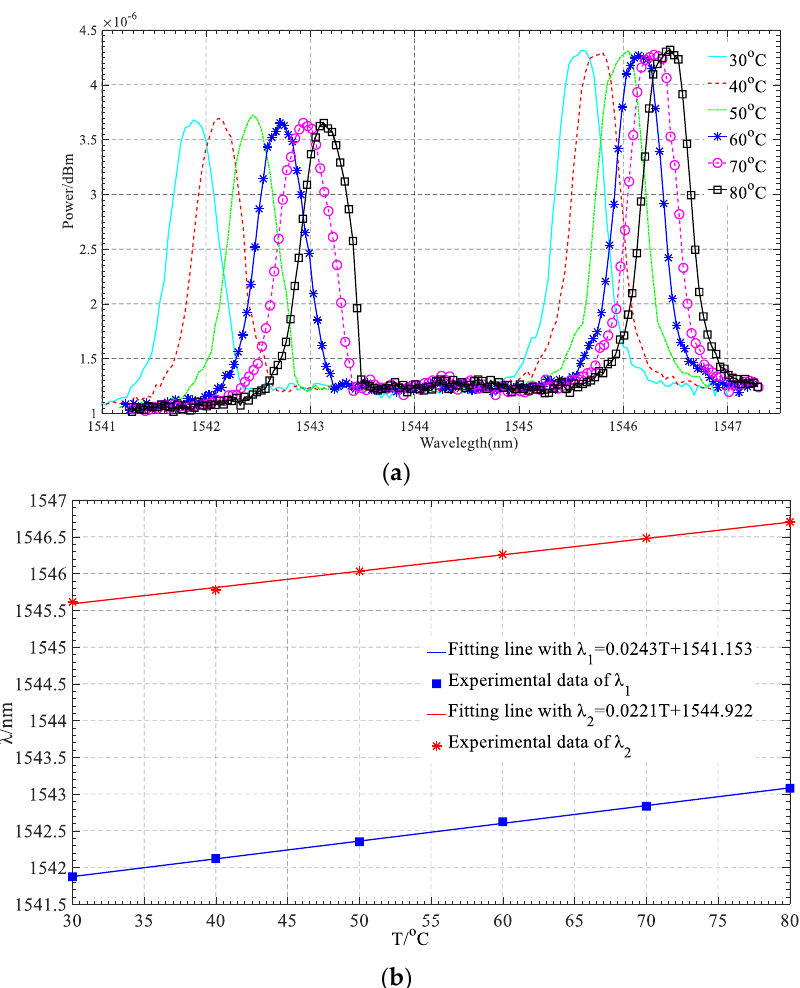
Figure 4. Temperature sensing of Type A ( a ) spectra at 30 to 80 °C. ( b ) temperature sensitivity.